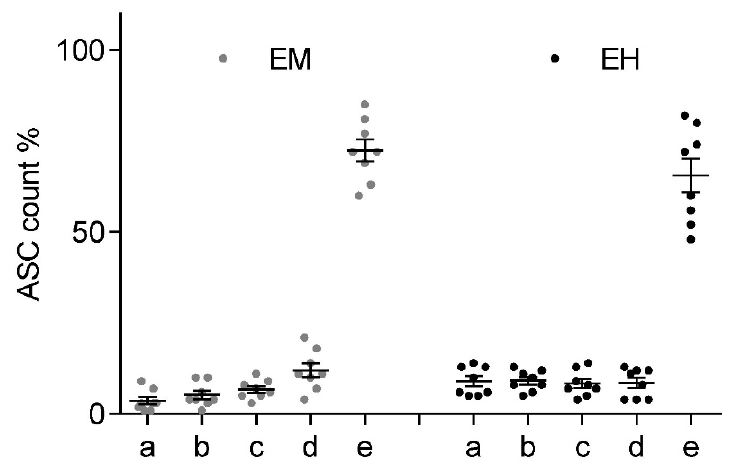
Figure 9. Fractional ASC count by 1 mL incremented fill-height (a–e) within a 15 mL Falcon tube after ESWT. No significant mixing is observed for either electromagnetic ( left ) or electrohydraulic ( right ) shockwave applicators at respective maximum energy settings.